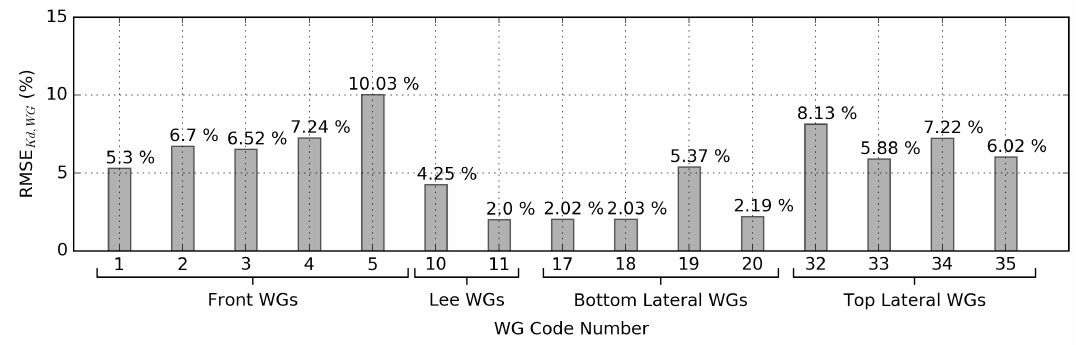
Figure 9. Root-Mean-Square-Error for the K d for all 15 WGs, RMSE K between the MILDwave-NEMOH coupled model and the WECwakes experimental